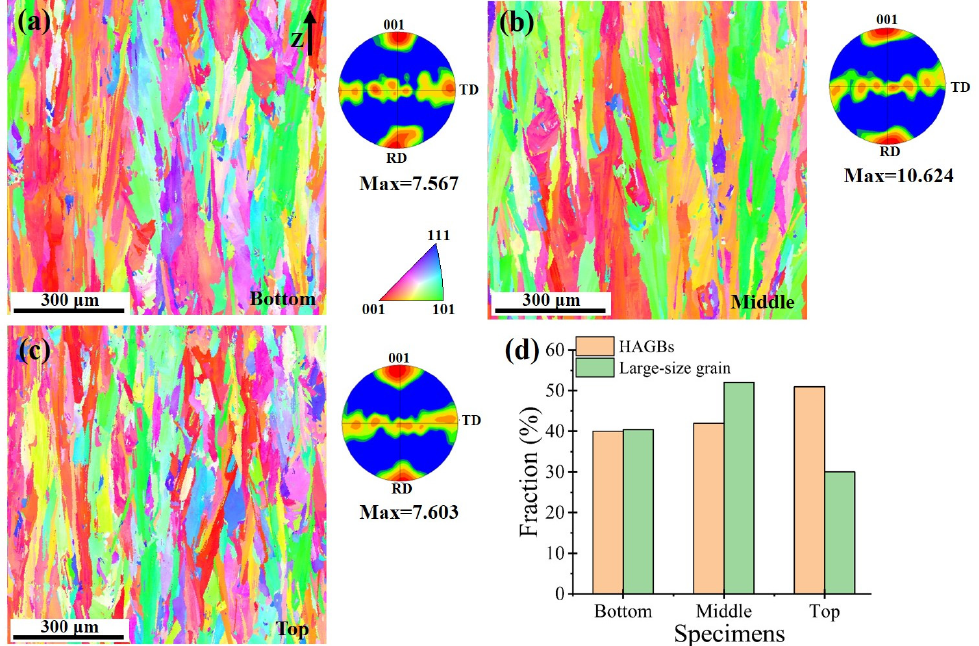
Table 3. Cooling rate predicted from experimental states.